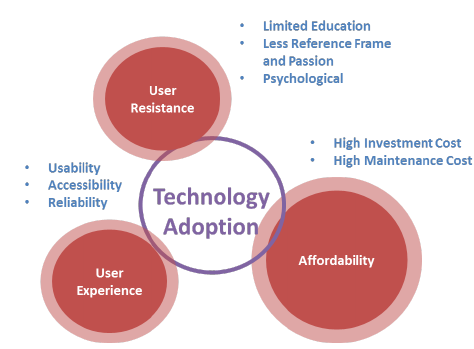
Figure 4. Technology